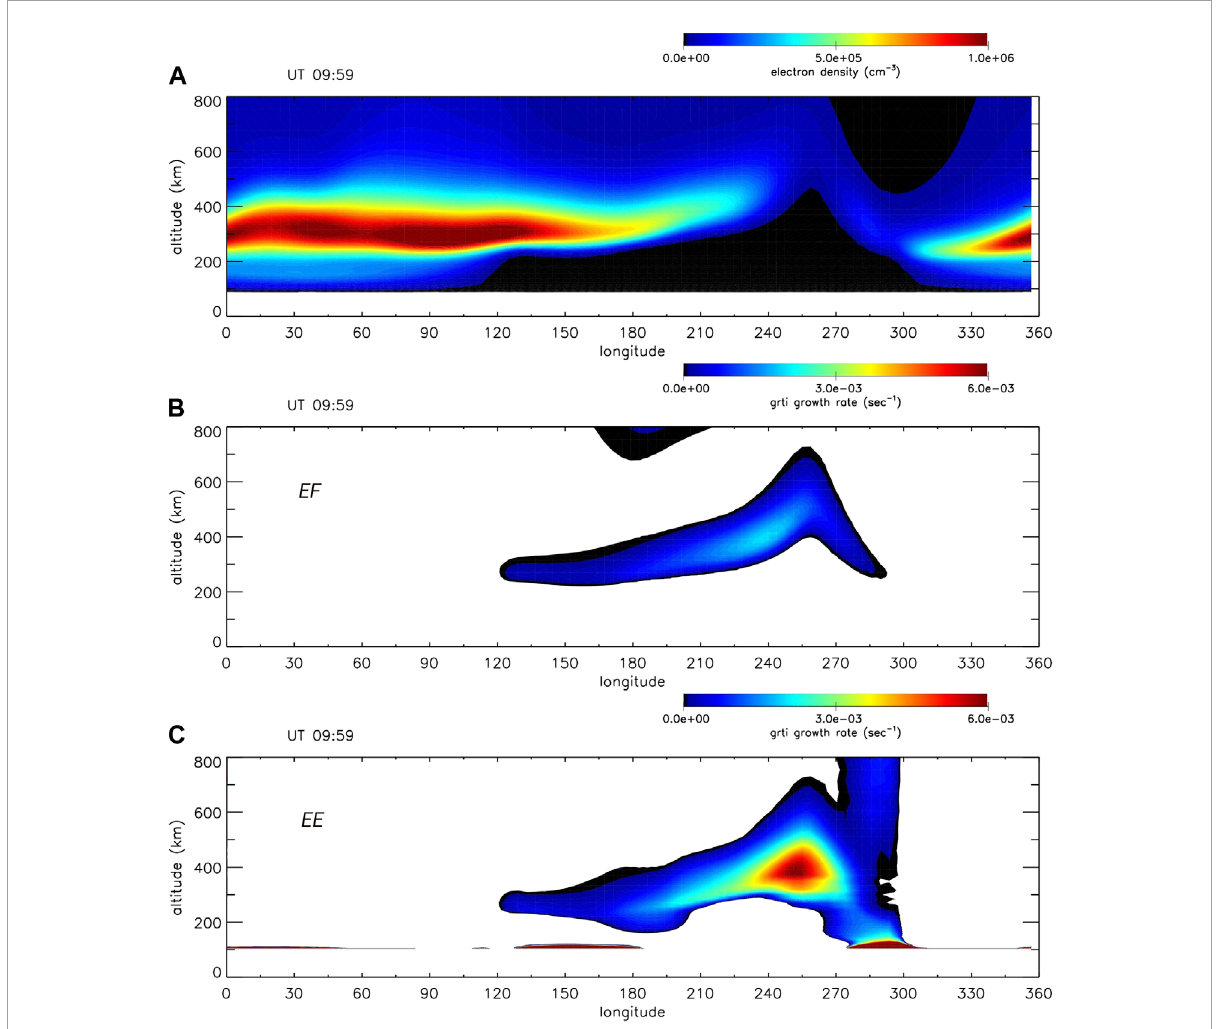
FIGURE 4 Contour plots of the electron density (A) , EF growth rate (B) , and EE growth rate (C) as a function of longitude and altitude at time ∼ 10:00 UT [from Huba (2022)].